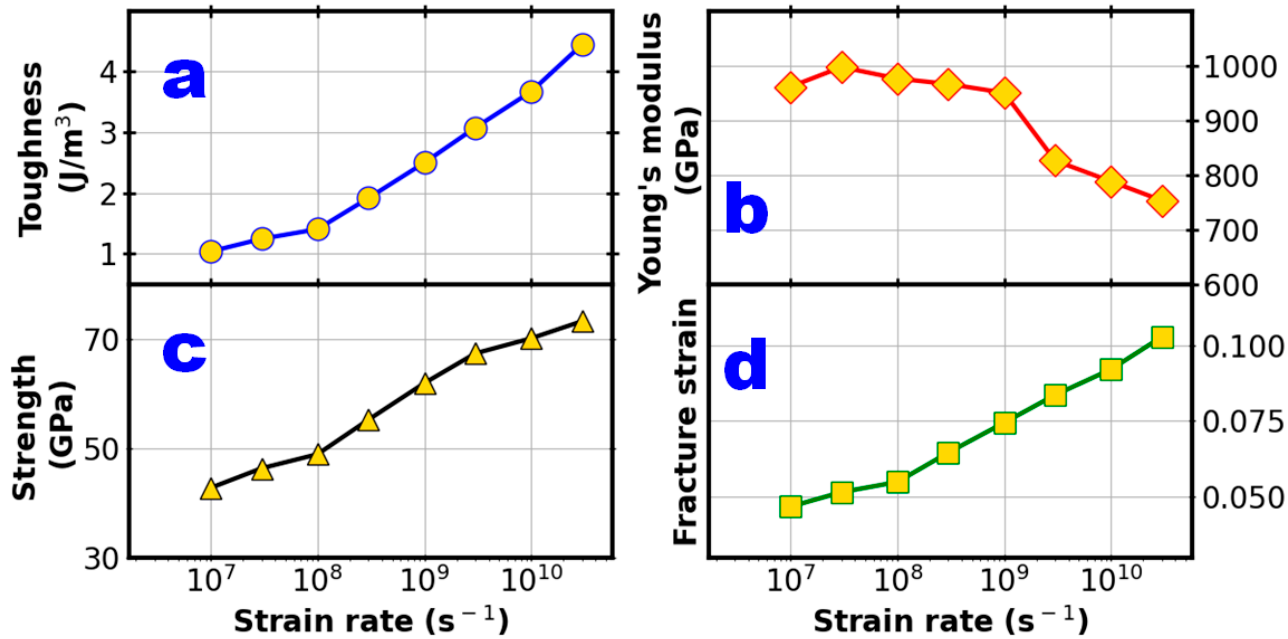
Figure 6. Strain rate dependence of cracked SLGSs’ mechanical properties: ( a ) toughness, ( b ) Young’s modulus, ( c ) fracture strength, and ( d ) fracture strain compared with that of pristine graphene. The strain rate ranges from 10 7 s − 1 to 3 × 10 10 s − 1 . The tensile simulations are under the following conditions: The temperature is 300 K. The pressure is 0.0001 GPa (1 atm). The model I loading is applied along the x axis (armchair direction). The system size is 4 × 4 (or 20.7 nm × 20.5 nm with 16,128 lattice sites). All the systems have the pre-crack in the shape of an isosceles right triangle.